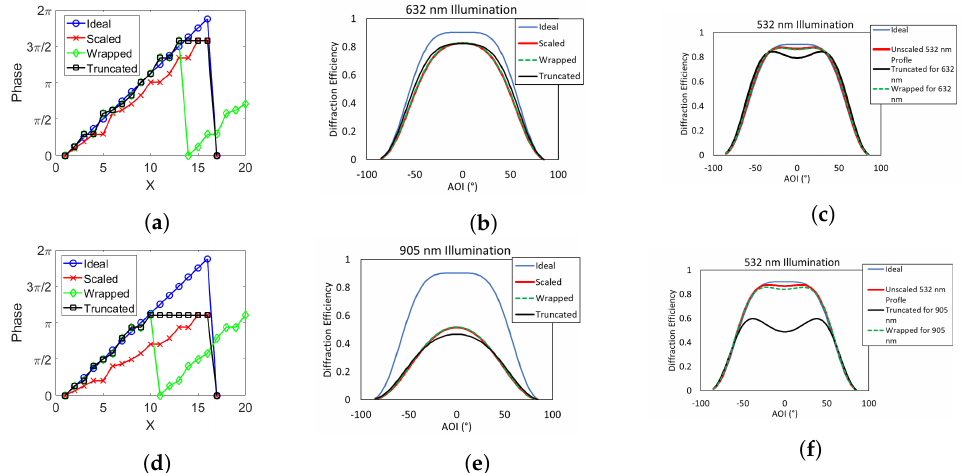
Figure 8. ( a ) Scaled, truncated, and wrapped phase profiles modified for a 632 nm operating wavelength, ( b ) simulated diffraction efficiency for phase profiles modified for 632 nm operating wavelength, ( c ) simulated diffraction efficiency for phase profiles modified for a 632 nm operating wavelength illuminated at 532 nm, ( d ) modified phase profiles for a 905 nm operating wavelength, ( e ) simulated diffraction efficiency for phase profiles modified for a 905 nm operating wavelength, and ( f ) simulated diffraction efficiency for modified profiles for a 905 nm operating wavelength illuminated at 532